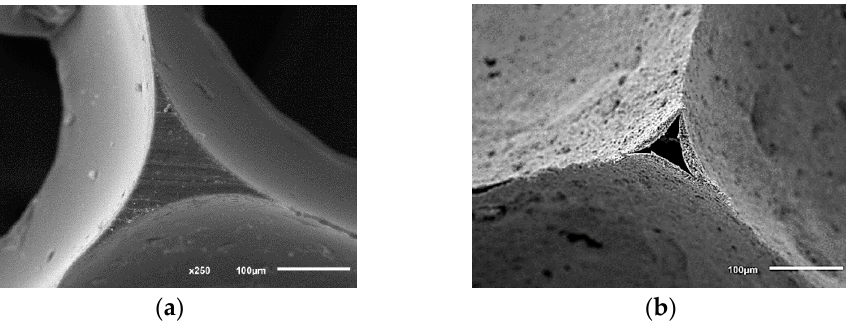
Figure 2. Typical SEM images of the fractured strut wall of ( a ) polyurethane foam, and ( b ) a reticulated porous ZTA specimen .